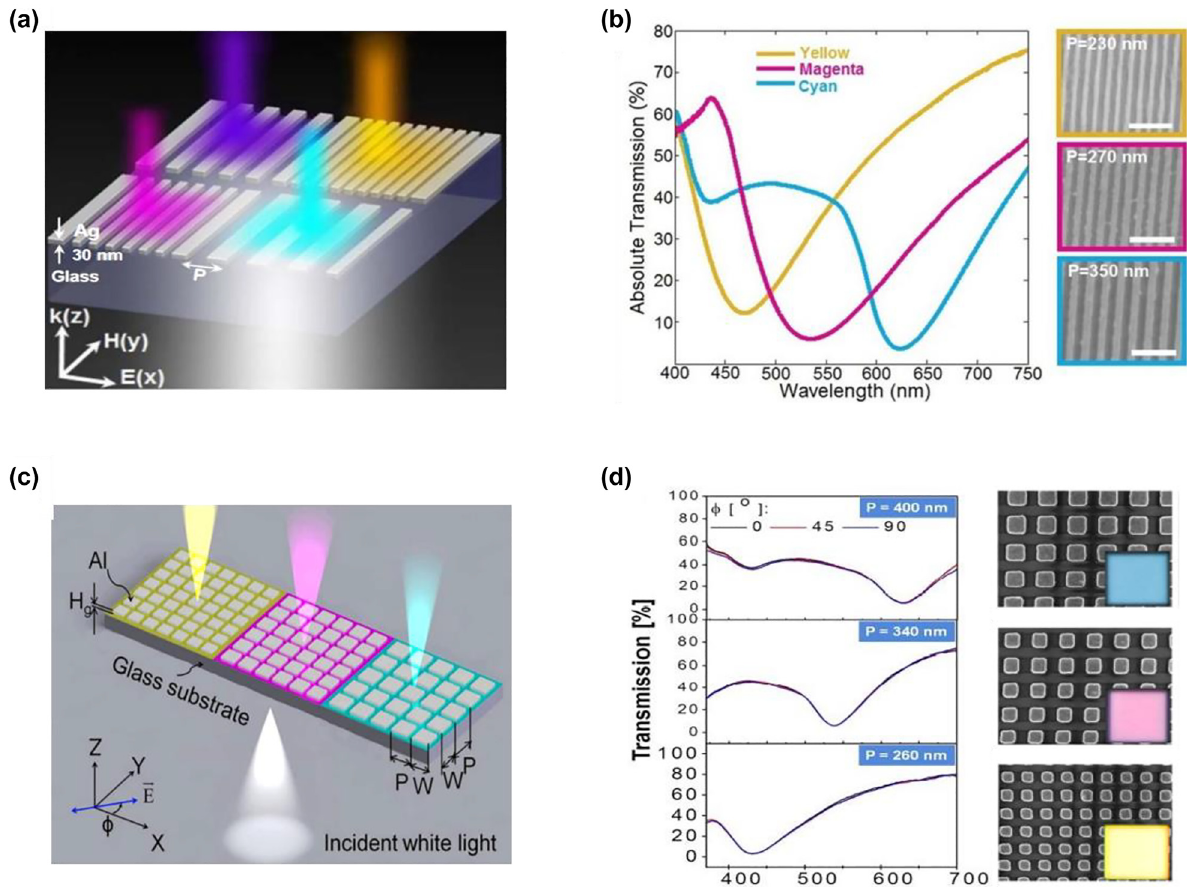
Figure 11: Plasmon resonance for structural color generation. (a) Schematic diagram of a 1D plasmonic nanostructure, consisting of 30 nm-thick Ag nano-gratings arrayed over a period of P on a glass substrate. (b) Left panel: experimentally measured transmission spectra under normally-incident, TM polarized light. For the three transmission colors of yellow, magenta, and cyan, the grating’s filling ratio is fixed at 0.5 while its period is set as 230 nm, 270 nm, and 350 nm, respectively. Right panel: corresponding SEM images. Scale bar: 1 μ m. Reproduced with permission [142]. Copyright ) Al nano-patches on a glass 2013, Nature Publishing Group. (c) Schematic diagram of a 2D plasmonic nanostructure, consisting of 40 nm thick ( H g substrate. (d) Left panel: Transmission spectra of three different samples measured under illumination light of different polarization directions. Periods of the Al nano-patches are chosen as 400 nm, 340 nm, and 260 nm, respectively, and the filling ratio (W/P) is fixed as 0.5. Right panel: corresponding SEM images and generated colors (insets) of the three samples. Modified with permission [143]. Copyright 2014, American Chemical Society.